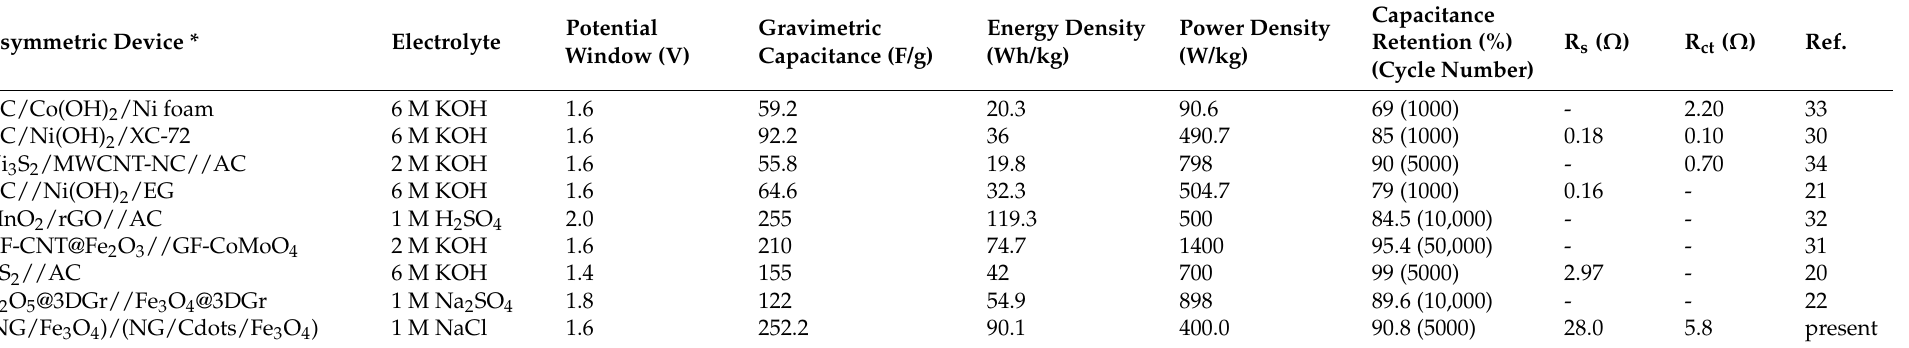
Table 1. Comparison of gravimetric capacitance, energy density, power density and capacitance retention for asymmetric supercapacitor devices measured with different electrolytes over wide voltage